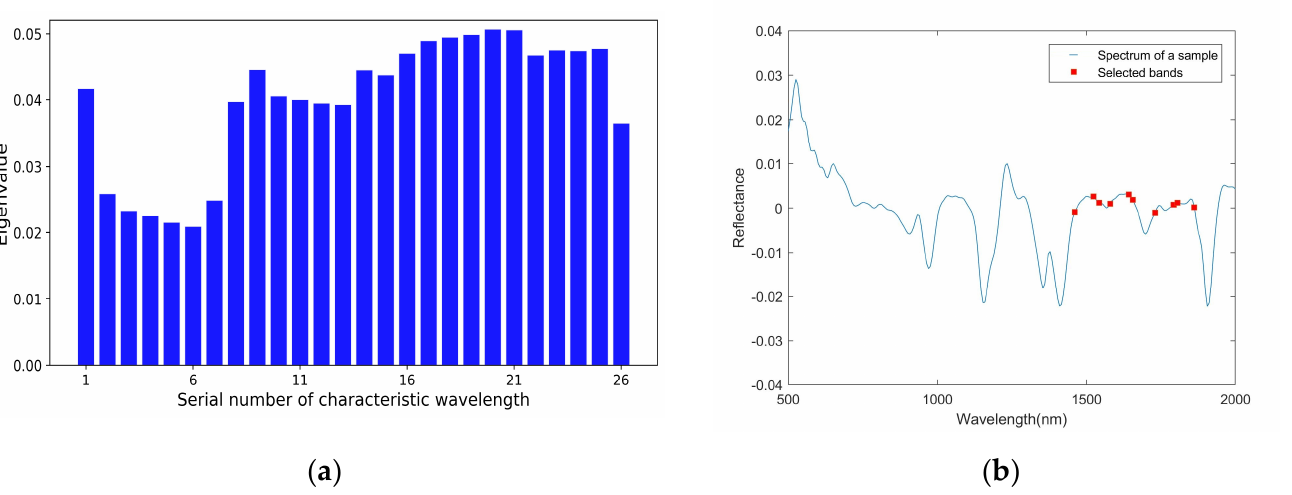
Figure 7. Results of the fine selection wavelengths by SPA-GDI algorithm. ( a ) The eigenvalues of each wavelength calculated by GDI. ( b ) Selected characteristic wavelengths by GDI.